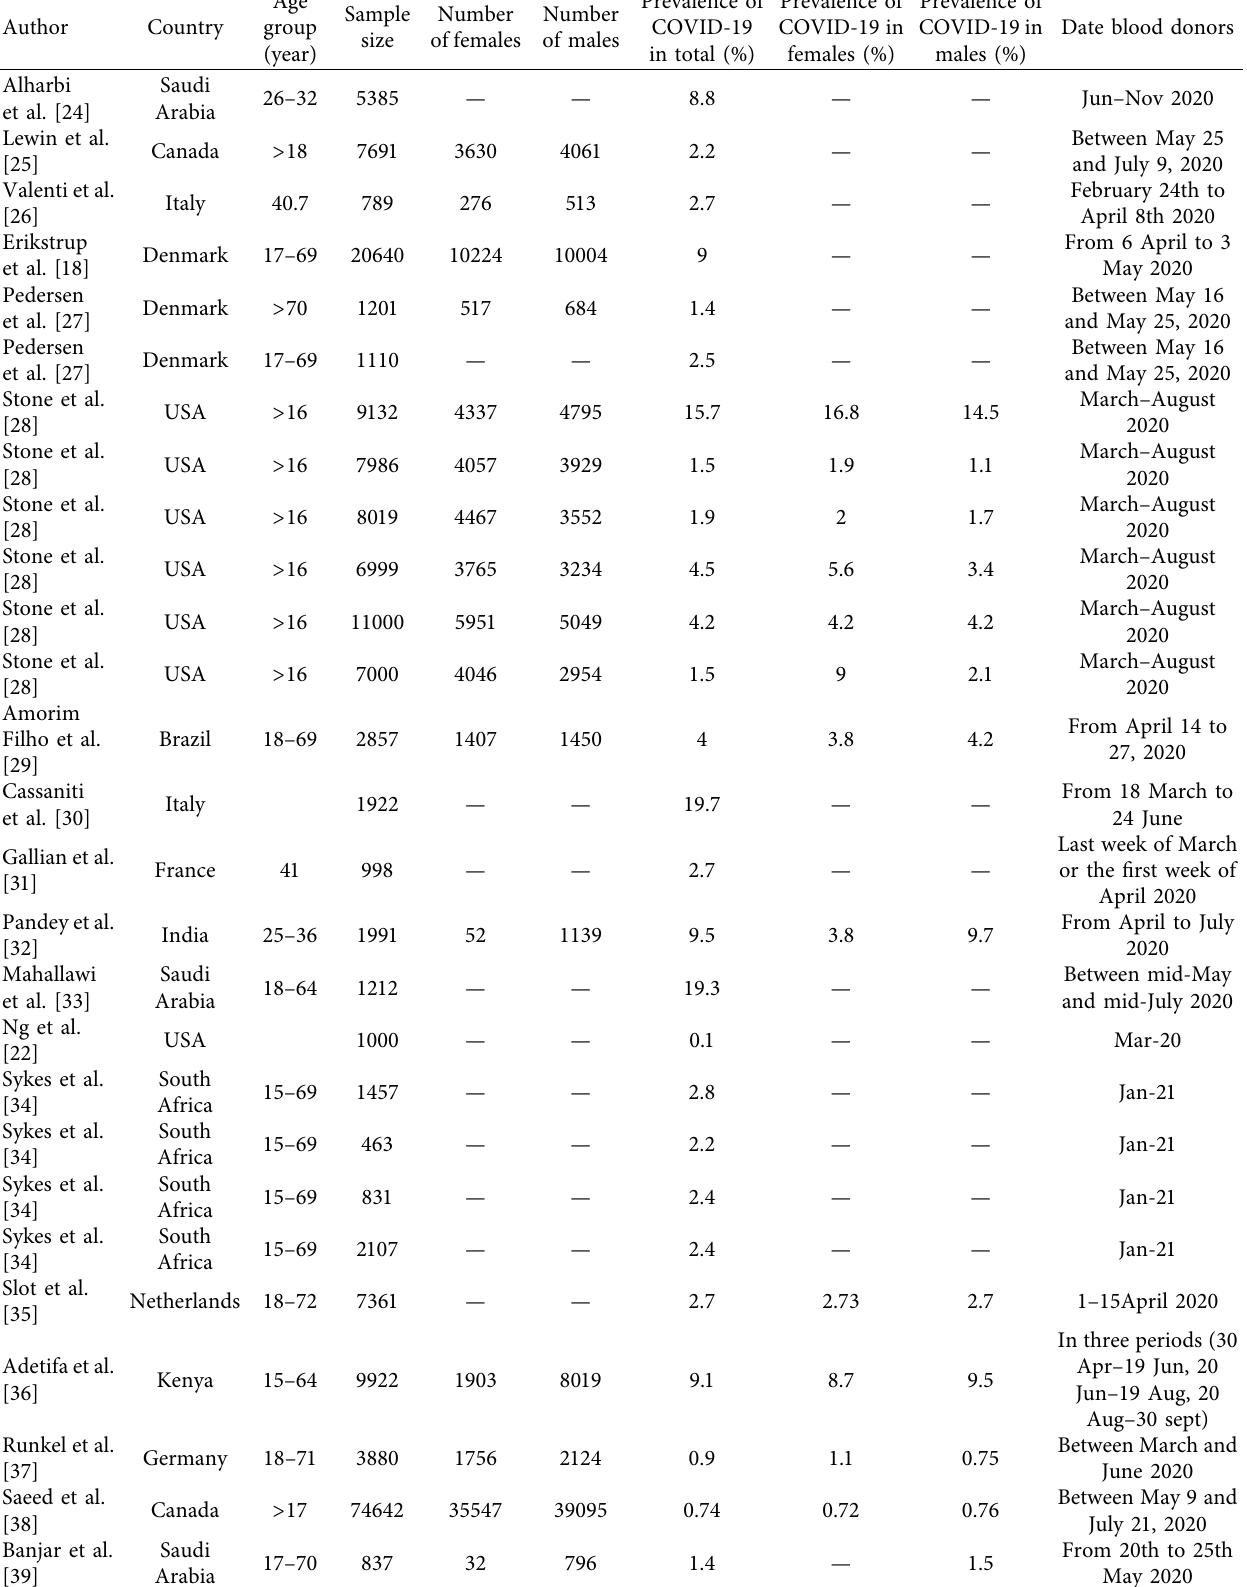
Table 1: Summary characteristics of included